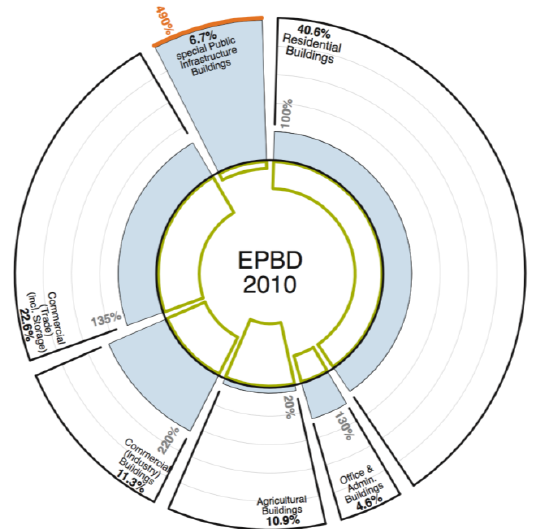
Figure 1. The new building volume in 2014 in Germany with the energy demand of each typical usage zone, as well as its potential for renewable energies (own representation according to [4]).